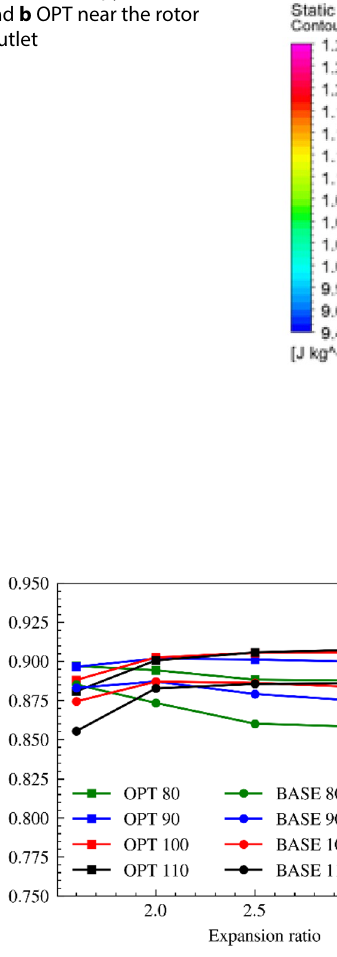
Fig. 15 Static entropy for a BASE and b OPT near the rotor blade outlet